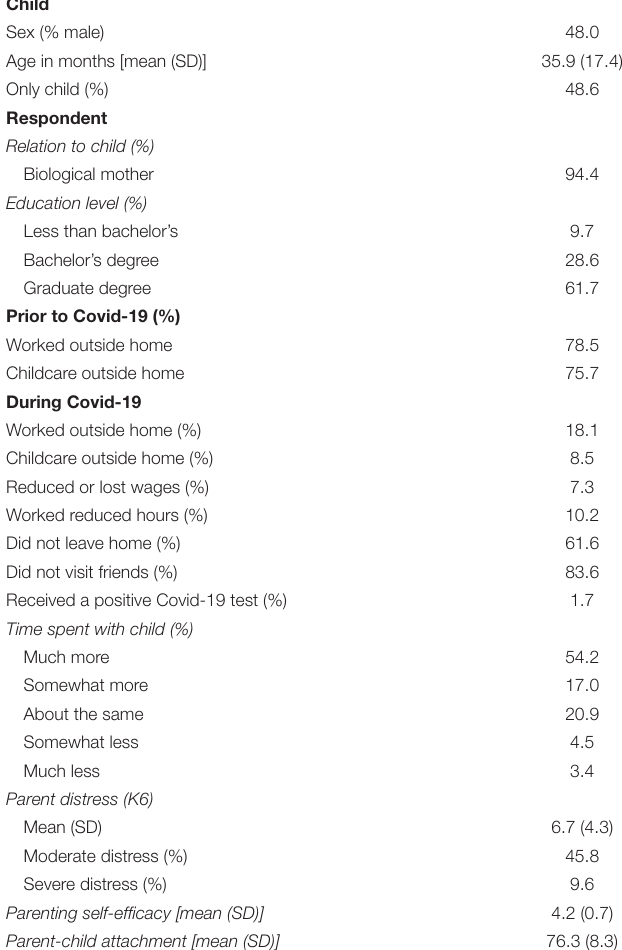
TABLE 1 | Sample ( n = 177) Demographics and Covid-19